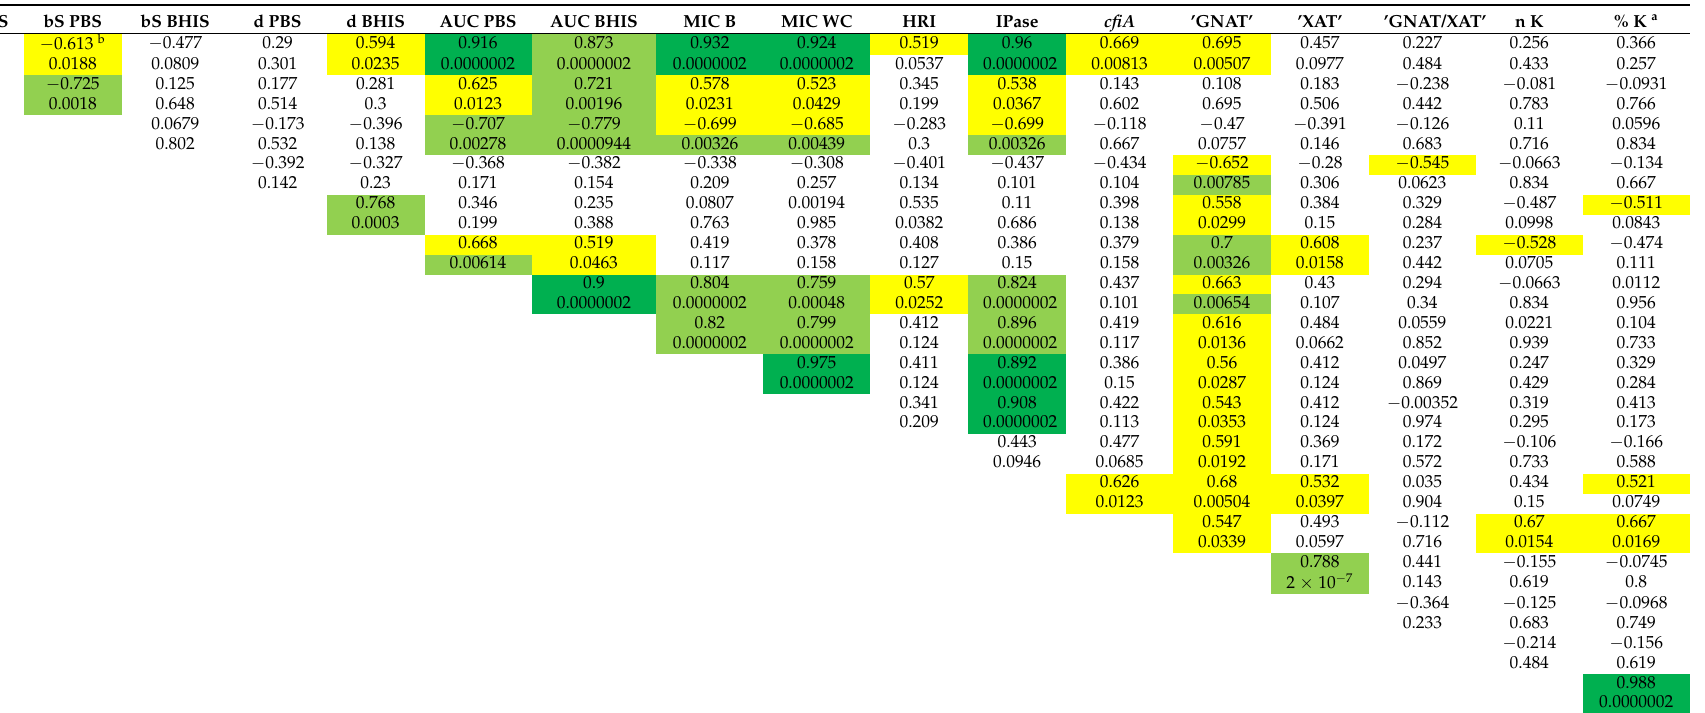
Table 3. Cross-correlation values of all strains of the traits examined (from Table